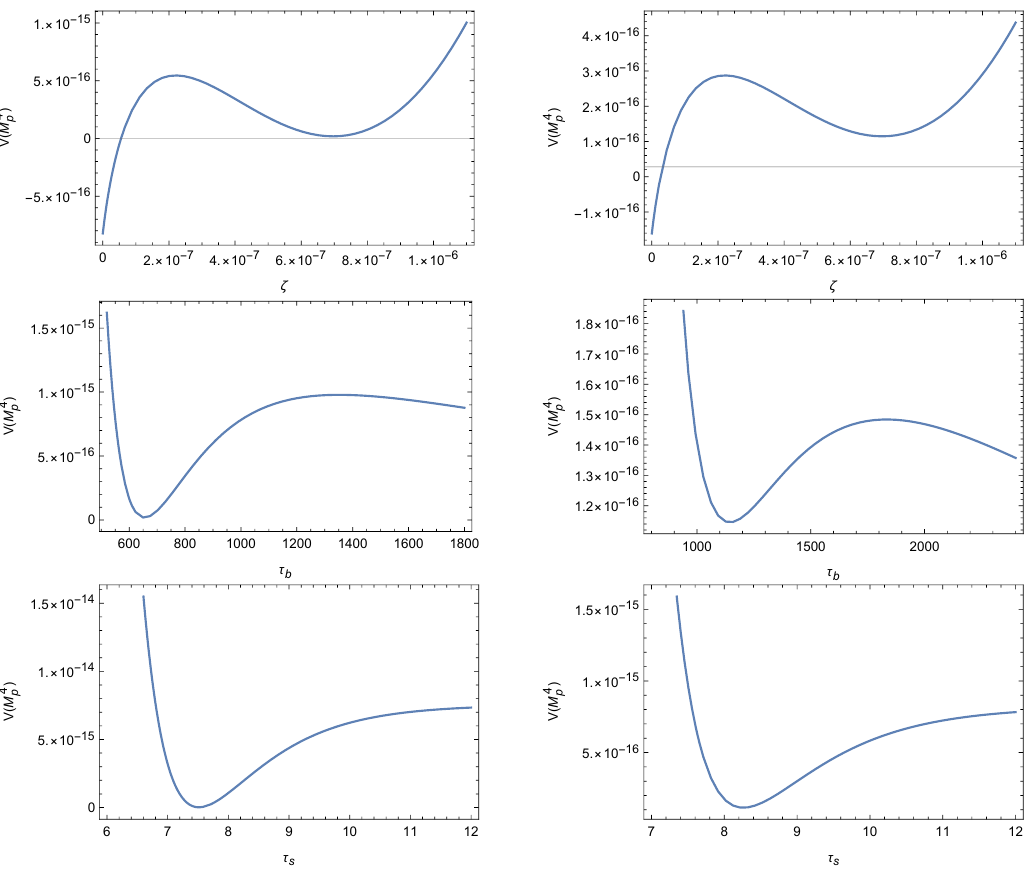
Figure 2. Plots of the potential (4.11) in each direction ( τ s , τ b , ζ ) near the minimum (left) and the saddle point (right), for the choice of parameters in table